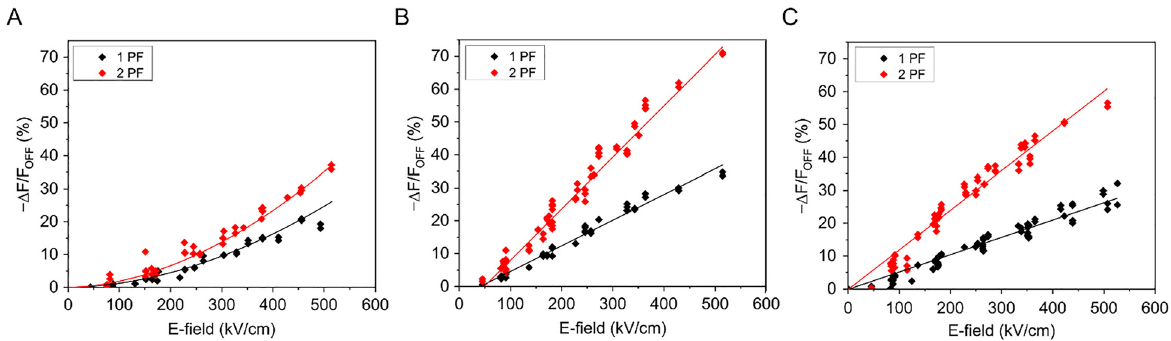
Figure 2: Electric field induced decrease of the fluorescence intensity, Δ F / F OFF , under 1P excitation (460 – 495 nm) in black and 2P excitation (900 nm) in red for the type-I QD6-PSMA (panel A), the quasi-type-II QD9-PSMA (panel B) and the quasi-type-II QR35-PSMA (panel C). Every point represents a single measurement. Data are fi t with a power low y 0 + a . x b . The obtained values for y 0, a and b are listed in Table 2.